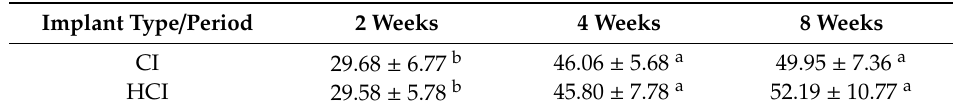
Figure 5. Mean and standard deviation for BV/TV data obtained through microtomographic analysis of all groups. Different letters represent different levels of statistically significant differences among the periods within each group (p < 0.05). One-way ANOVA complemented by the Tukey test. Table 2. Data on the mean and standard deviation for BV/TV data obtained through microtomographic analysis of all groups.